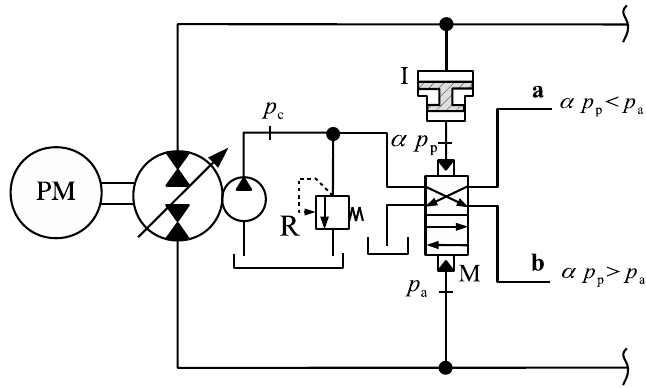
Figure 27. Signal generator for correctly determining the operation quadrant.